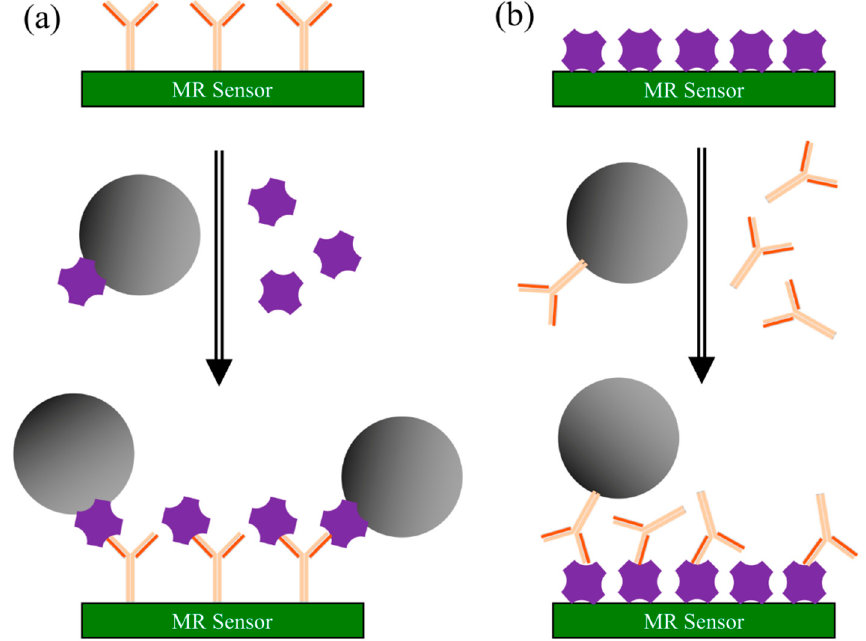
Figure 6. Schematic view of competitive binding assays. ( a ) MR sensor surface pre-coated with capture antibodies. The MNP-labeled antigens are competing with unlabeled antigens from testing samples for the antibody binding sites; ( b ) MR sensor surface pre-coated with antigens. The MNP-labeled antibodies are competing with unlabeled antibodies from testing samples for the antigen binding sites.